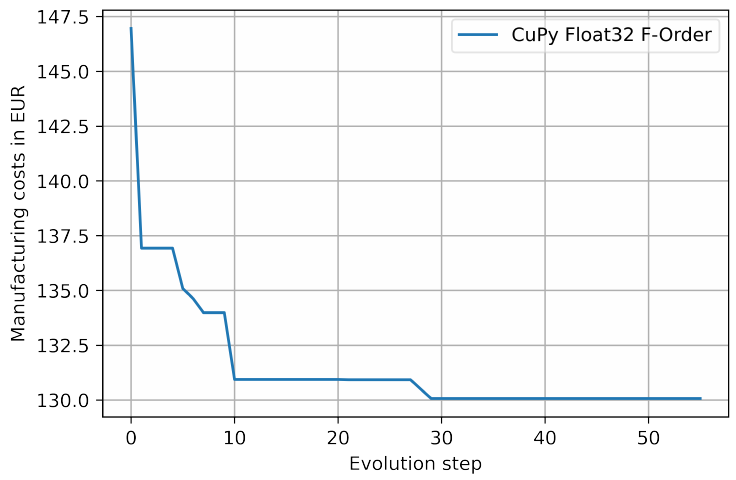
Figure 10. Manufacturing costs vs. differential evolution steps with 100,000